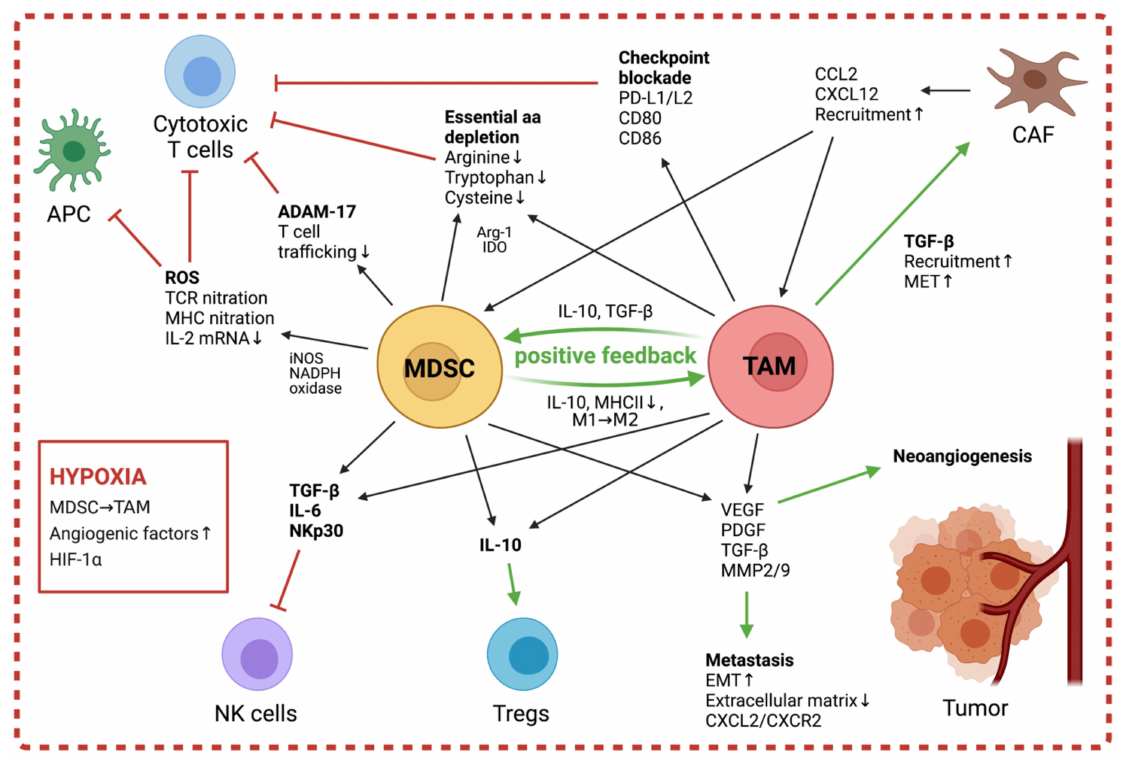
Figure 2. Suppressive mechanisms exerted by myeloid cells in the tumor microenvironment (TME) and their effects on its cellular components. Green arrows indicate stimulatory effects and red bar headed lines indicate inhibitory effects on